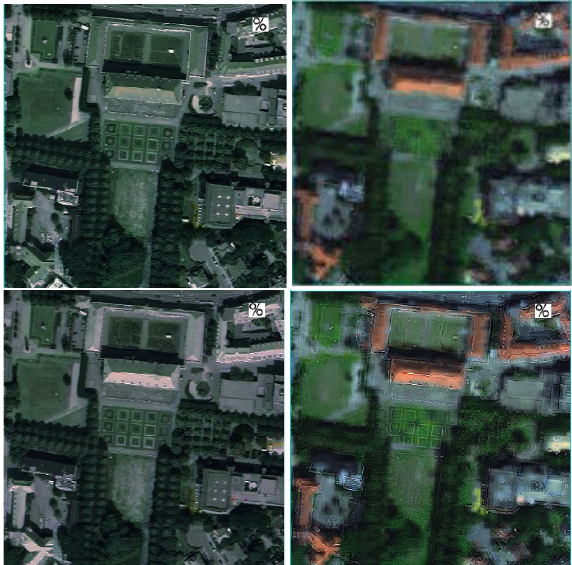
Figure 6. Ehlers hyperspectral image sharpen results from (a) spectral average of aerial photo as pan and band-pass filter with cut-off ranges from 100 to 150; (b) spectral average of aerial photo as pan and high-pass filter with cut-off range of 100; (c) red band of aerial photo as pan and band-pass filter with cut-off range from 100 to 150; (d) red band of aerial photo as pan and high-pass filter with a cut-off range of 100.